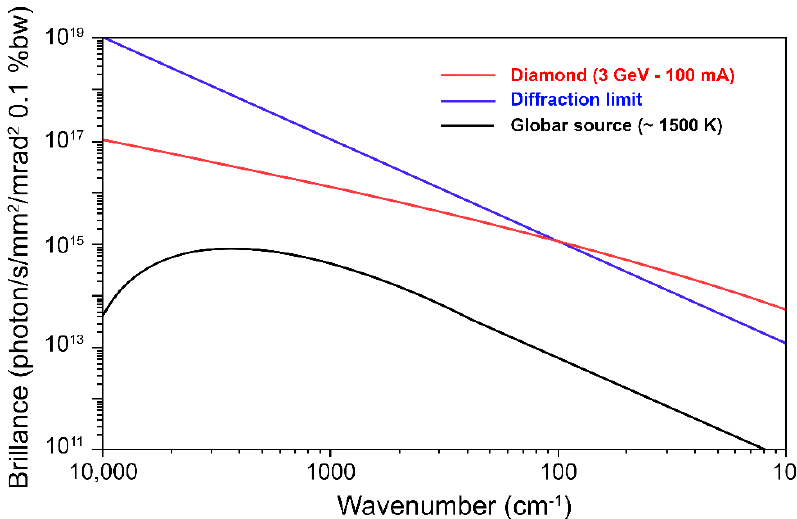
Figure 3. Comparison of the calculated SR brilliance of a 3 GeV SR source (red), a Globar (black), and an ideal bending magnet SR diffraction limited source (blue). Reprinted with permission from Reference [5].